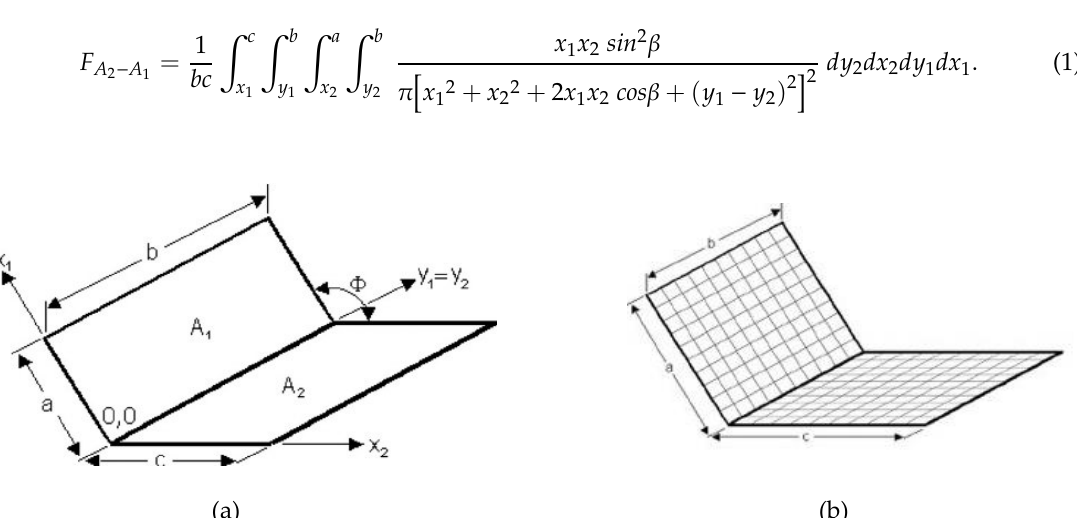
Figure 3. Radiation view factor analysis: ( a ) Two rectangles with one common edge and ( b ) the reflecting and receiving surface with uniform grids [11].